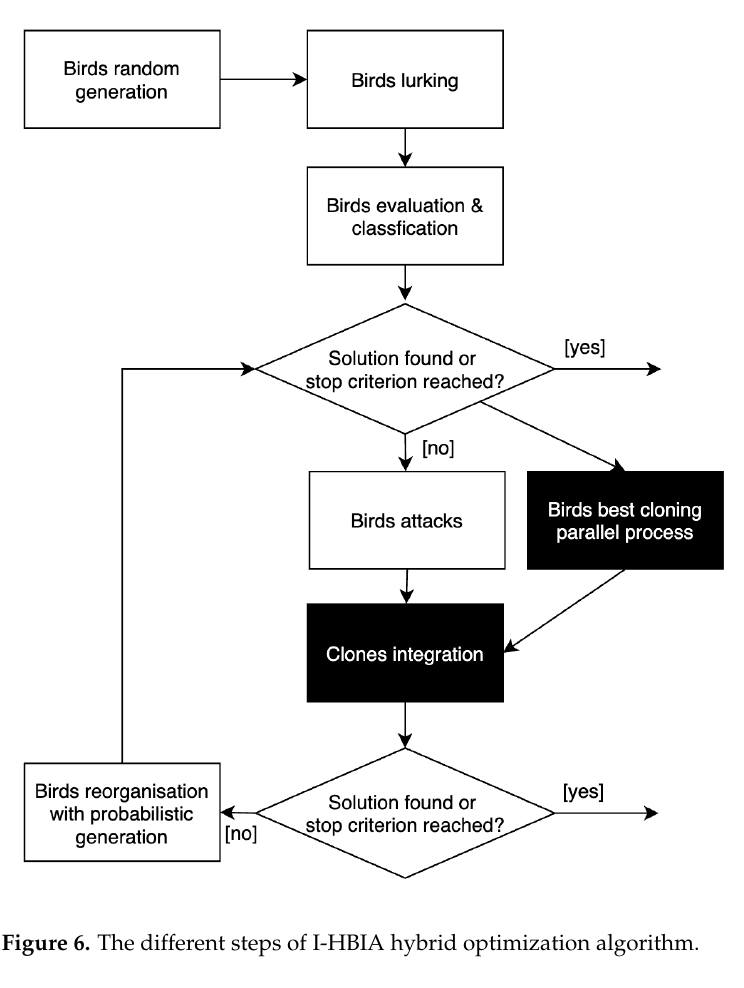
Figure 6. The different steps of I-HBIA hybrid optimization algorithm.